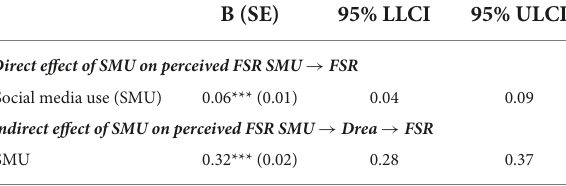
TABLE 4 Two risk characteristics as parallel